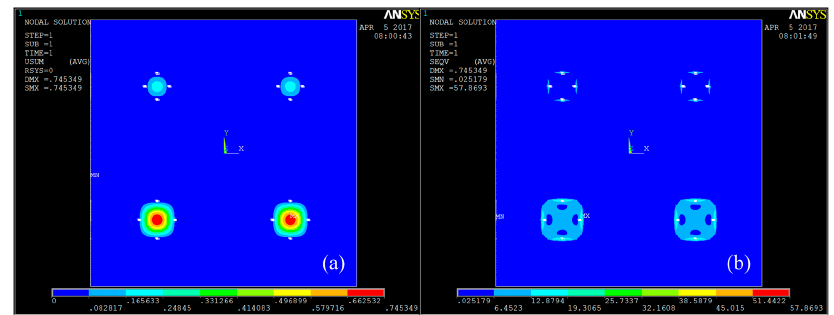
Figure 3. ( a ) Top view of finite element (FE) model of the array-type pressure sensor; ( b ) bottom view of FE model of the array-type pressure sensor; ( c ) three-dimensional FE mesh of the array-type pressure sensor; and ( d ) three-dimensional FE mesh of the piezoresistor area.